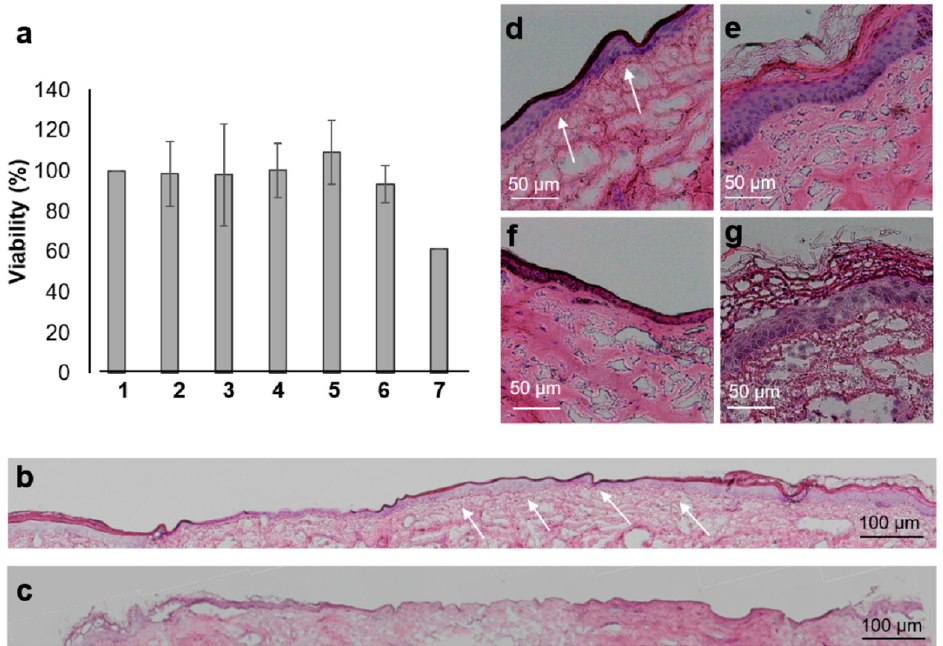
Figure 3. Local toxicity of ciprofloxacin delivered using PVP-foils. ( a ) The XTT assay was run with a skin biopsy previously treated for 20 h with: 0.9% NaCl (1); PVP foils prepared from solutions in ddH 2 O (2); PVP foils prepared from solutions in 30% acetic acid (3); PVP foils loaded with 11 µ g (4), 250 µ g (5), and 500 µ g (6) of ciprofloxacin; and 50 µ g of PVP-coated silver nanoparticles (7). Means and standard deviations from three independent experiments are reported. ( b , c ) Picture collage of H&E stained sections after 9 days of tissue culture of ( b ) an untreated wound and ( c ) a wound treated with a PVP foil loaded with 250 µ g ciprofloxacin. ( d–g ) Details from the centre ( d , f ) and the edges ( e , g ) of control ( d , e ) and treated ( f , g ) wounds. Arrows show a newly formed epithelial